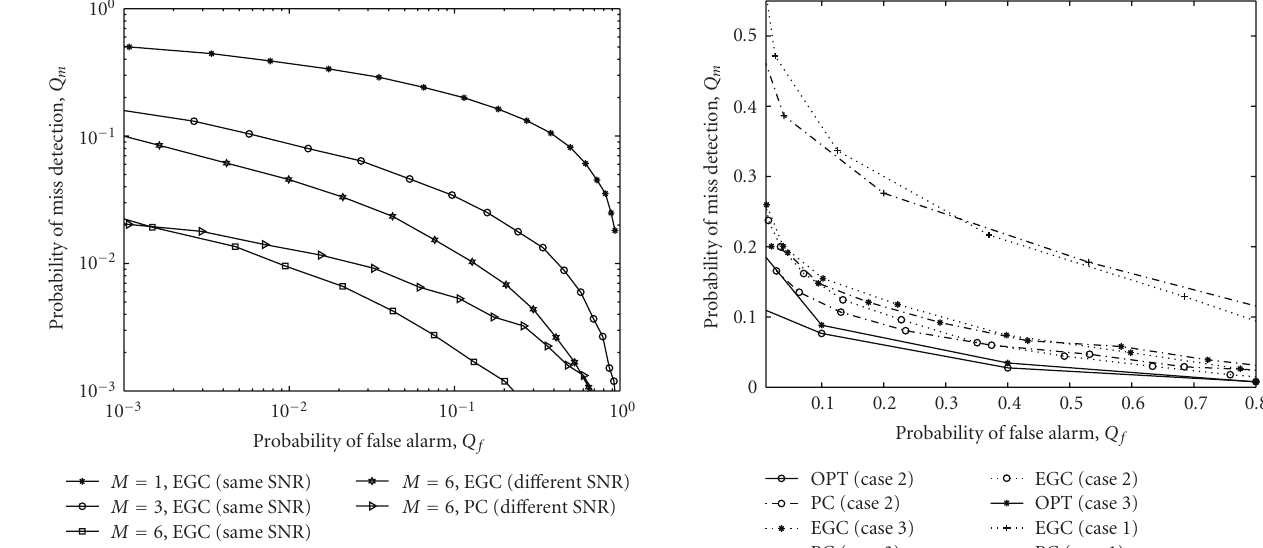
Figure 17: Receiver operating characteristics for collaborative spectrum sensing for 6 users in Rayleigh fading channel with im- perfect reporting channels, N = 10 (Case 1: All users have good reporting channel, Case 2: All users have bad reporting channel, and Case 3: Two of the users have good reporting